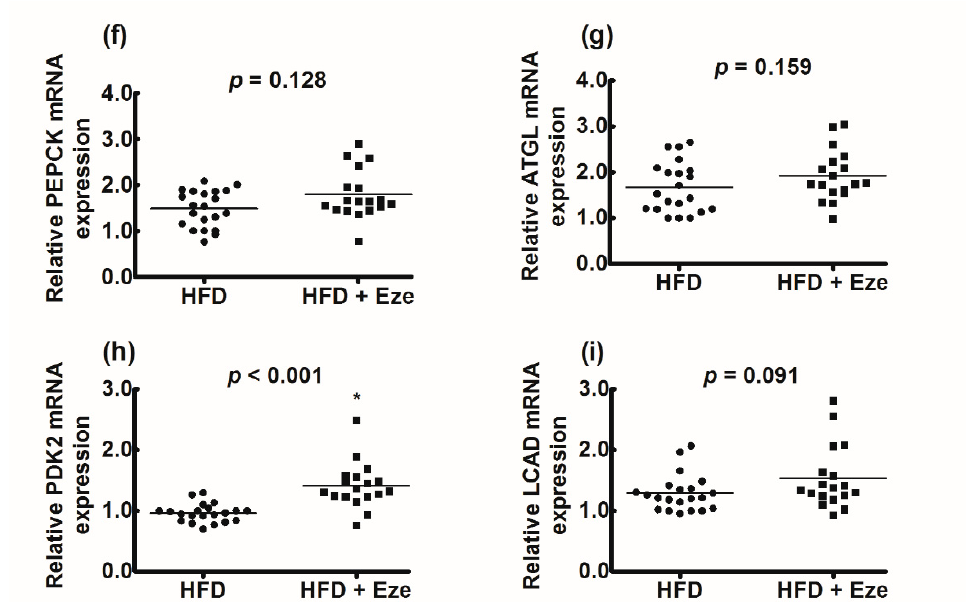
Figure 3. E ff ects of ezetimibe on the sizes of adipocytes, markers of inflammation, and genes involved in lipogenesis, lipolysis, and β -oxidation. ( a ) The e ff ects of ezetimibe on the sizes of adipocytes were compared using two-sample t-test for a total of 1,300 adipocytes ( n = 100 per animal). The sizes of the adipocytes were markedly reduced in the ezetimibe group, compared to those in the control group ( p < 0.001). ( b ) The e ff ects of ezetimibe on markers of inflammation: (upper panel) pro-inflammatory cytokines and (lower panel) anti-inflammatory cytokines. ( c ) LPL, ( d ) Lipin1, ( e ) Perilipin, ( f ) PEPCK, ( g ) ATGL, ( h ) PDK2, and ( i ) LCAD. Compared using the Wilcoxon-Mann-Whitney U test; * p < 0.05. LPL; lipoprotein lipase, PEPCK; phosphoenolpyruvate carboxykinase, ATGL; adipose triglyceride lipase, PDK2; pyruvate dehydrogenase kinase-2, LCAD; long-chain acyl-CoA